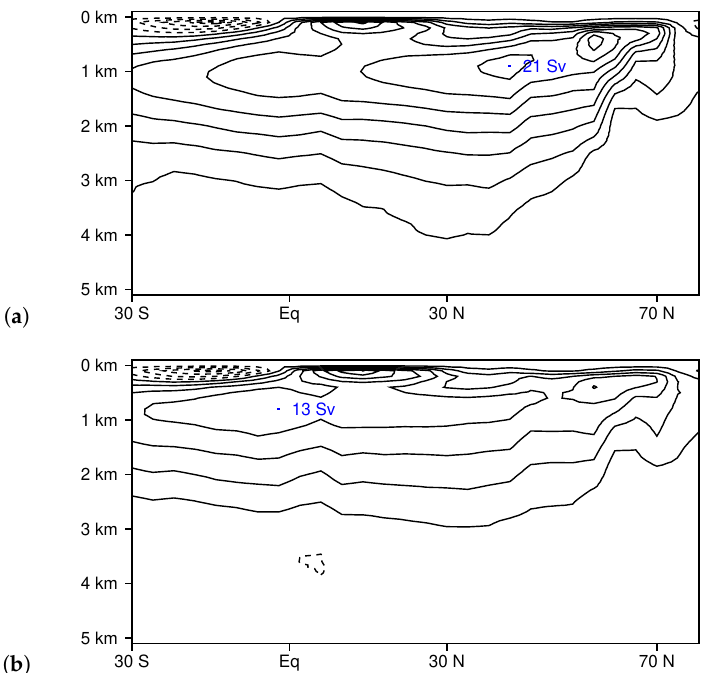
Figure 10. Meridional overturning streamfunction (3 Sv contour interval). ( a ) Simulation with mixing. ( b ) Simulation without mixing. Positive (negative) contours are drawn with solid (dashed) lines, with contour values ranging from − 10.5 to 22.5